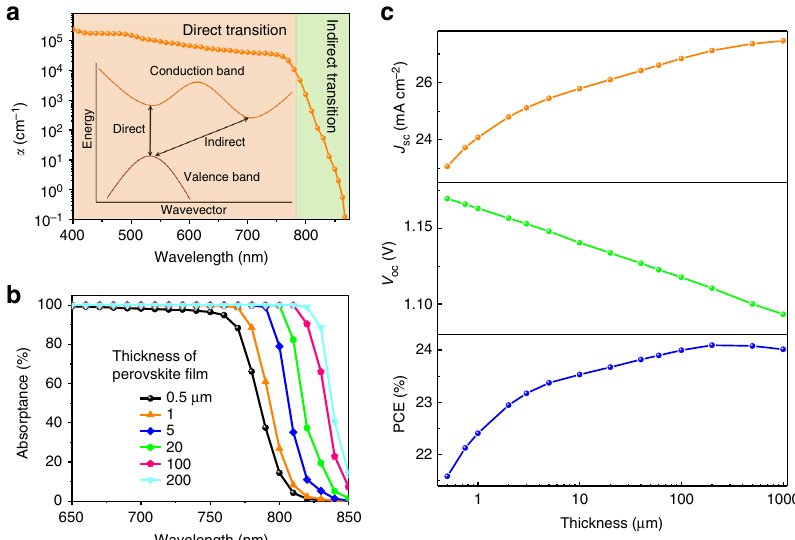
Fig. 1 Thickness-dependent perovskite absorption and device performance. a Schematic illustration of the direct, below-bandgap transitions and absorption coef fi cient of methylammonium lead triiodide (MAPbI 3 ) from a polycrystalline fi lm. b The calculated absorption of MAPbI 3 fi lms with different thickness. c The calculated ideal dependence of J sc , V oc , and PCE of the single crystal solar cells on the thickness of the thin single